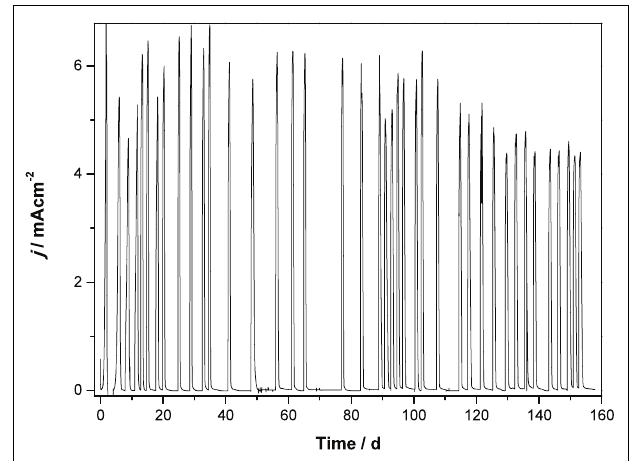
FIGURE 6 | 40 batch cycles (160days) of a continuously monitored secondary biofilm experiment .The applied potential was 0.2V, the temperature was